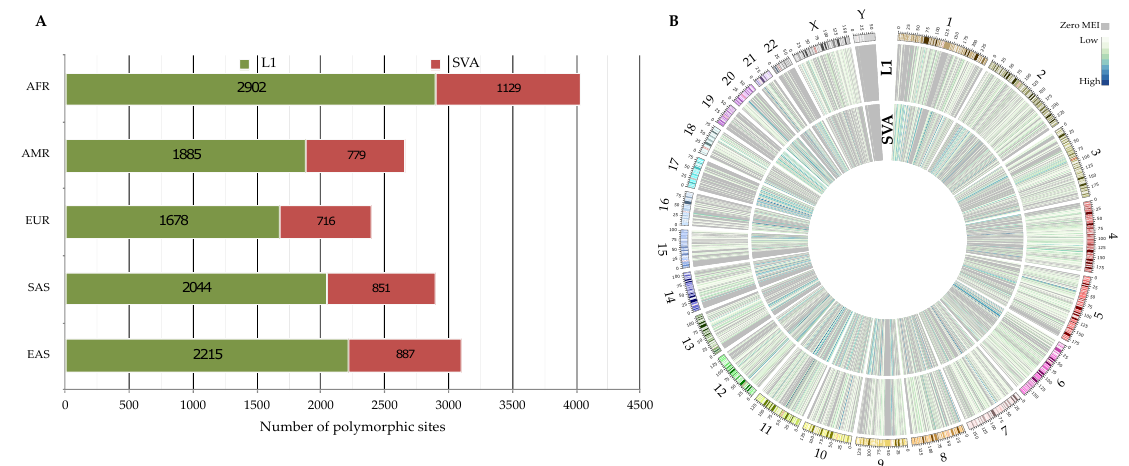
Figure 2. Polymorphic non-reference MEIs across 3202 genomes. ( A ) The number of identified polymorphic MEIs within super-populations. ( B ) The genome-wide density of identified MEIs in this study. The heatmaps are the number of polymorphic L1s and SVAs per 1 Mbp. The ideogram depicts the human chromosomes (GRCh38) with their cytogenetic bands.